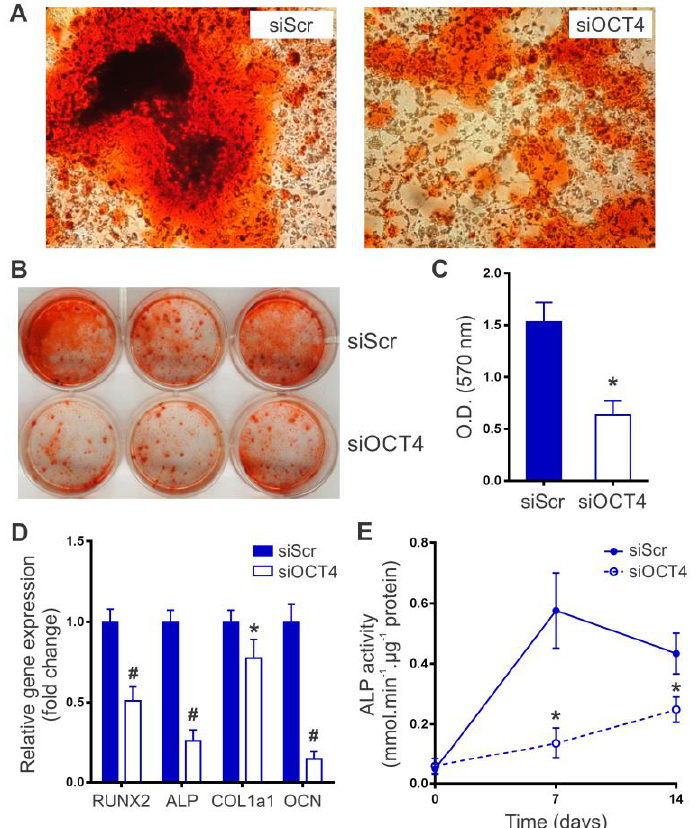
Figure 3. OCT4 silencing impairs MSC osteogenic differentiation. OCT4 siRNA (siOCT4) and scrambled siRNA (siScr) MSCs were cultured in osteogenic differentiation medium. ( A ) Representative images of Alizarin Red S staining to visualize mineralized bone matrix at day 21 (magnification x200). ( B ) Representative macroscopic image of wells after MSC osteogenic differentiation. ( C ) Quantification of calcium mineral content as determined by absorbance at 570 nm after dye elution from wells in ( B ). Results are expressed as mean ± SD ( n = 6 per group); * p < 0.0001 derived from unpaired t test. ( D ) Quantitative RT-PCR analysis of osteogenic markers at seven days after differentiation. Results are expressed as mean ± SD ( n = 4 per group); * p < 0.05 and # p < 0.001 between groups derived from unpaired t -test. ( E ) Kinetics of alkaline phosphatase (ALP) activity during osteogenic differentiation. Results are expressed as mean ± SD ( n = 6 per group); * p < 0.001 between groups derived from unpaired t -test.